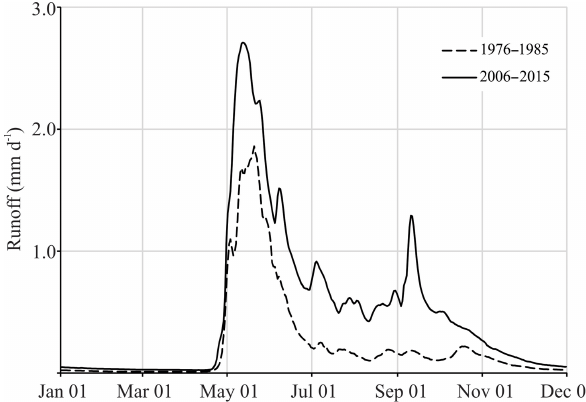
Figure 11. Composite hydrograph for two 10-year periods (1976– 1985 and 2006–2015) of runoff from the Jean Marie River